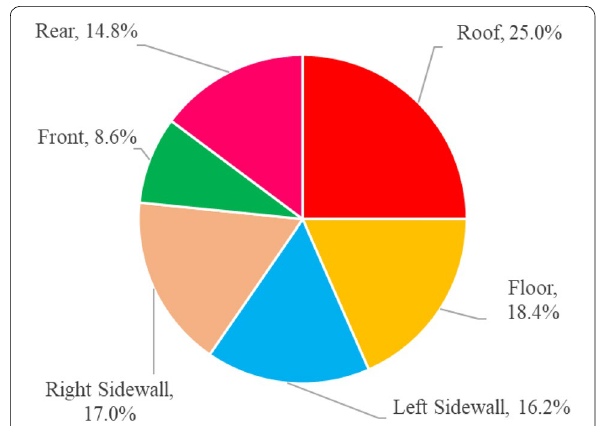
Figure 9 Contributions to the total sound power from different areas of the